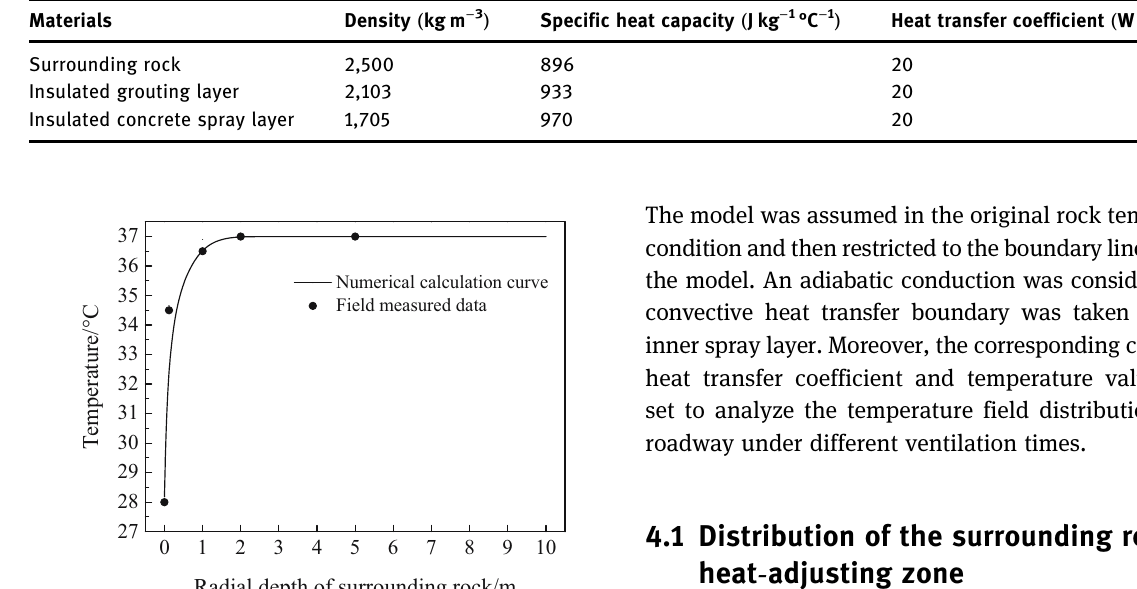
Radial depth of surrounding rock/m Figure 4: Comparison between calculation and measured